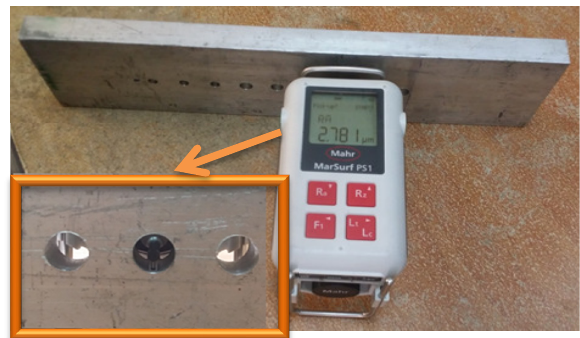
Fig. 3. Surface Roughness Device (Mahr / MarSurf PS1).